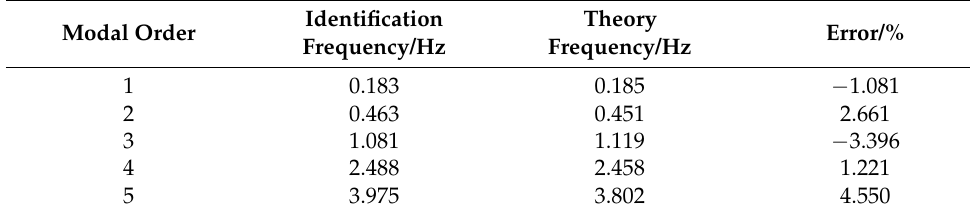
Figure 13. Test versus theoretical frequency response diagram. Table 7. Comparison diagram of identification modes. Table 6. Comparison of identification frequency.